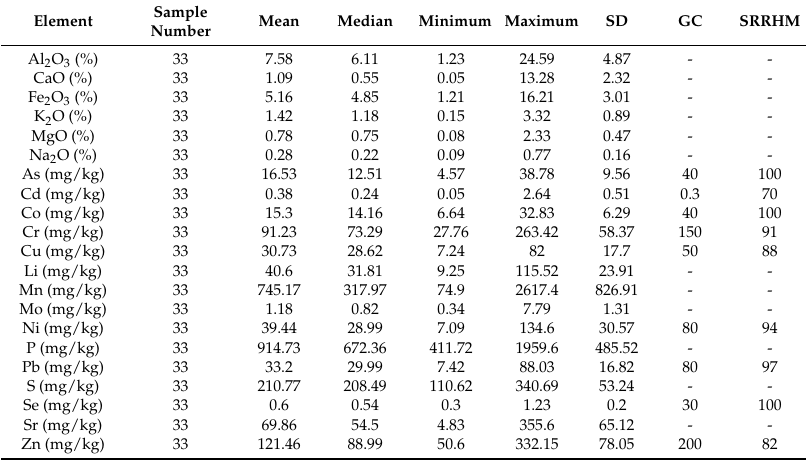
Table 3. Statistical analysis of trace element and mineral levels in soil in Hechi. Element Sample Number Mean Median Minimum Maximum